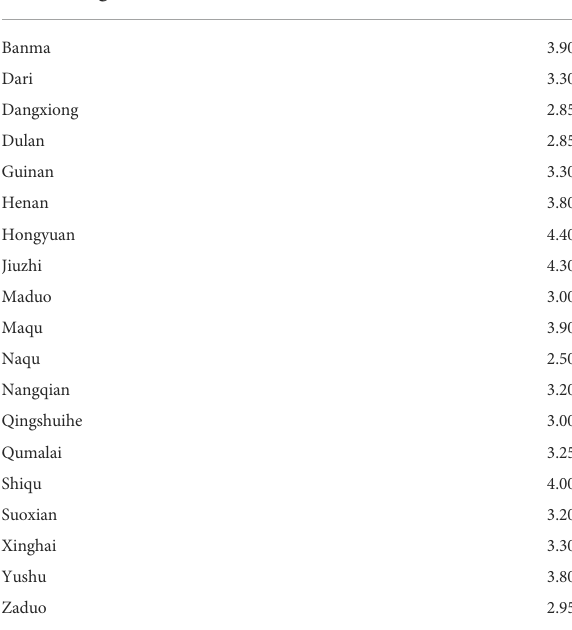
TABLE2Correlationcoef fi cientr,Nash-Sutcliffeef fi ciencycoef fi cient NSE and RMSE between simulated and observed freezing depths during the veri fi cation